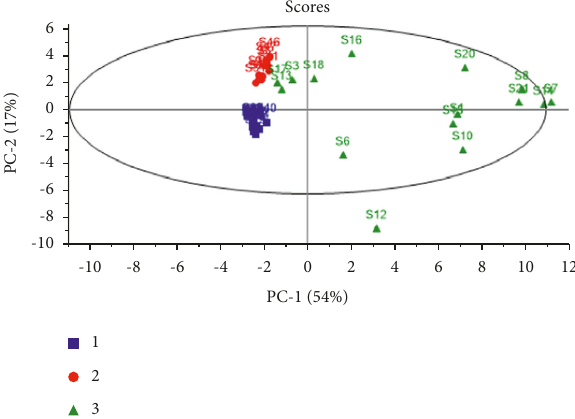
Figure 9: PCA score plot of 47 batches of Acacia catechu Loadings